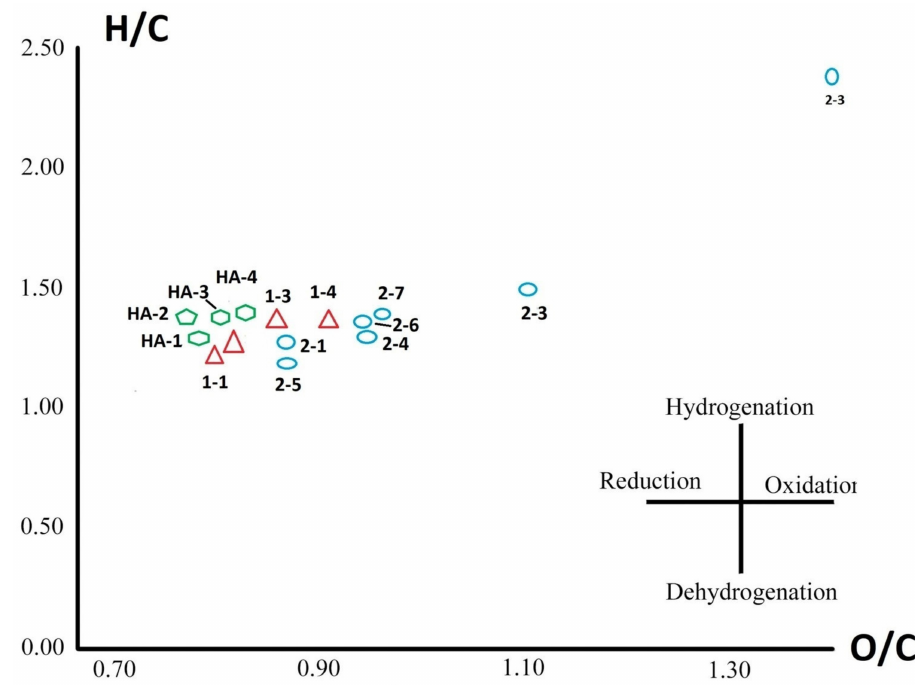
Figure 5. Van Krevelen diagram of the humic substances and organic